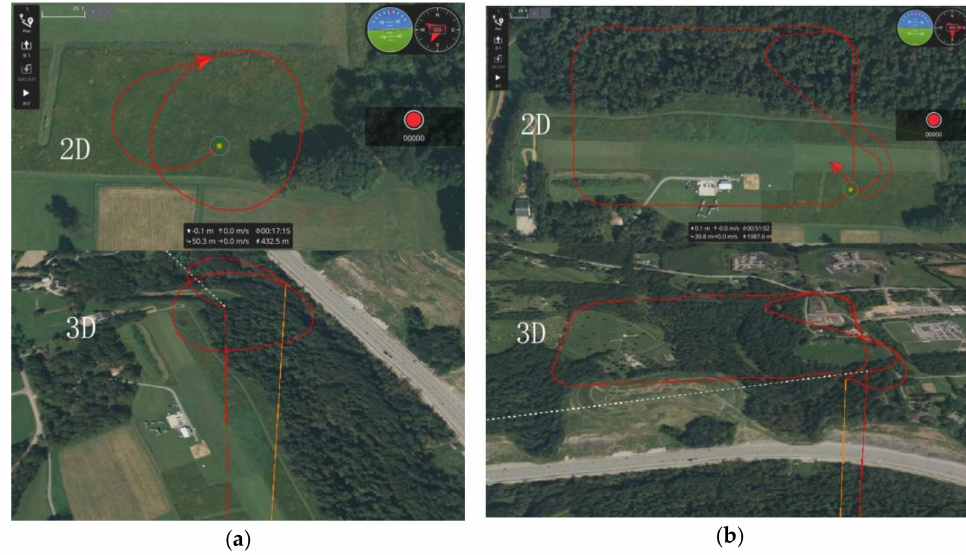
Figure 5. ( a ) The normal flight data. ( b ) The flight data of elevator